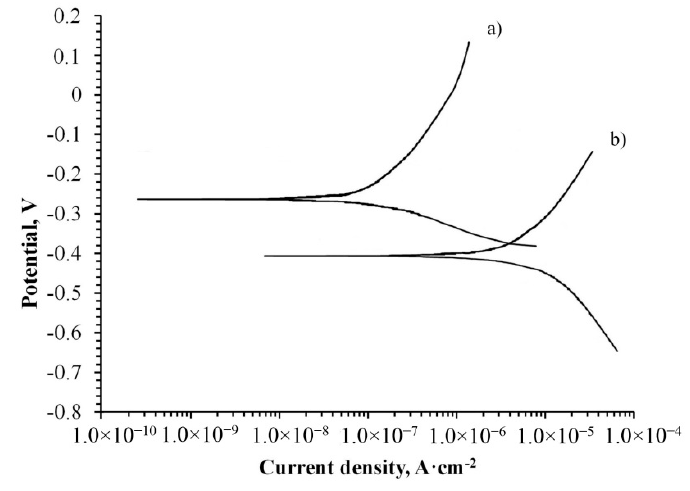
Figure 6. Potentiodynamic polarization curves for alloy Ti-6Al-4V (a) treated by MAO process and (b) untreated specimen. Both examined in 3.5 wt % NaCl.